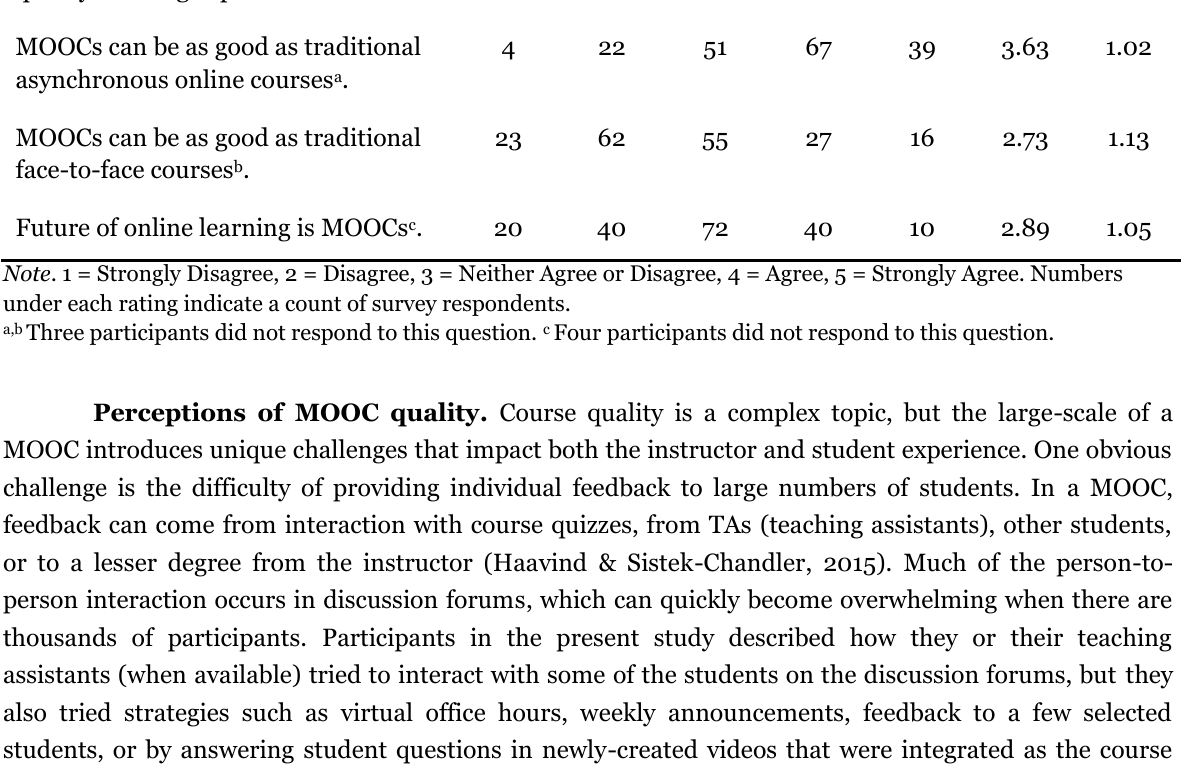
Perceptions of Educational Value